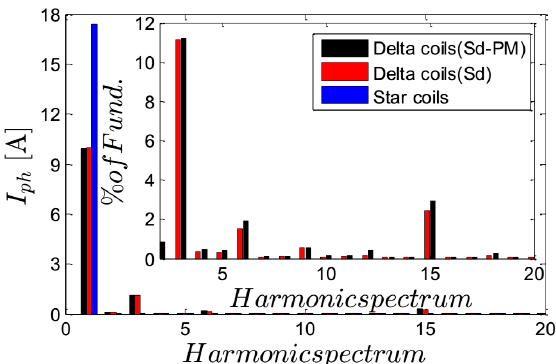
Figure 13. Harmonic spectrum of currents in star and delta coils at rated conditions and optimal current angles.